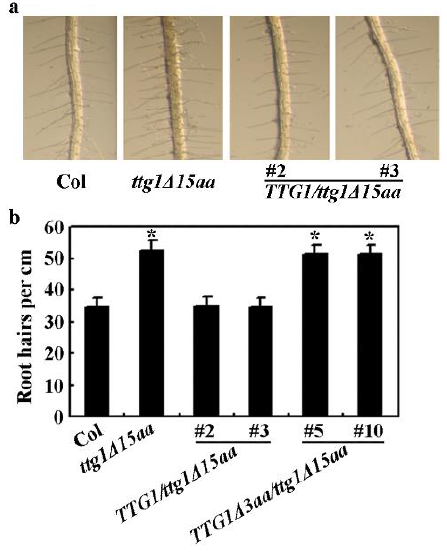
Figure 4. Expression of TTG1 under the control of its native promoter restores root hair formation in the ttg1Δ15aa mutant. ( a ) Root hair formation in the Col wild type, the ttg1Δ15aa mutant and the TTG1 / ttg1Δ15aa transgenic plants. Seeds of Col wild type, the ttg1Δ15aa mutant, and the TTG1 / ttg1Δ15aa transgenic plants were germinated and grown on ½ MS plates vertically. Pictures were taken from 7-day-old seedlings under a Motic K microscope by using an EOS 1100D digital camera. ( b ) Root hair density in seedlings of the Col wild type, the ttg1Δ15aa mutant, the TTG1 / ttg1Δ15aa , and the TTG1Δ3aa / ttg1Δ15aa transgenic plants. Root numbers were count under a Motic K microscope, and root hair density was calculated. Date represence mean ± SD of 17 – 18 seedlings. *, Significantly different from that in the Col wuld type (student’s t test, p < 0.0001).